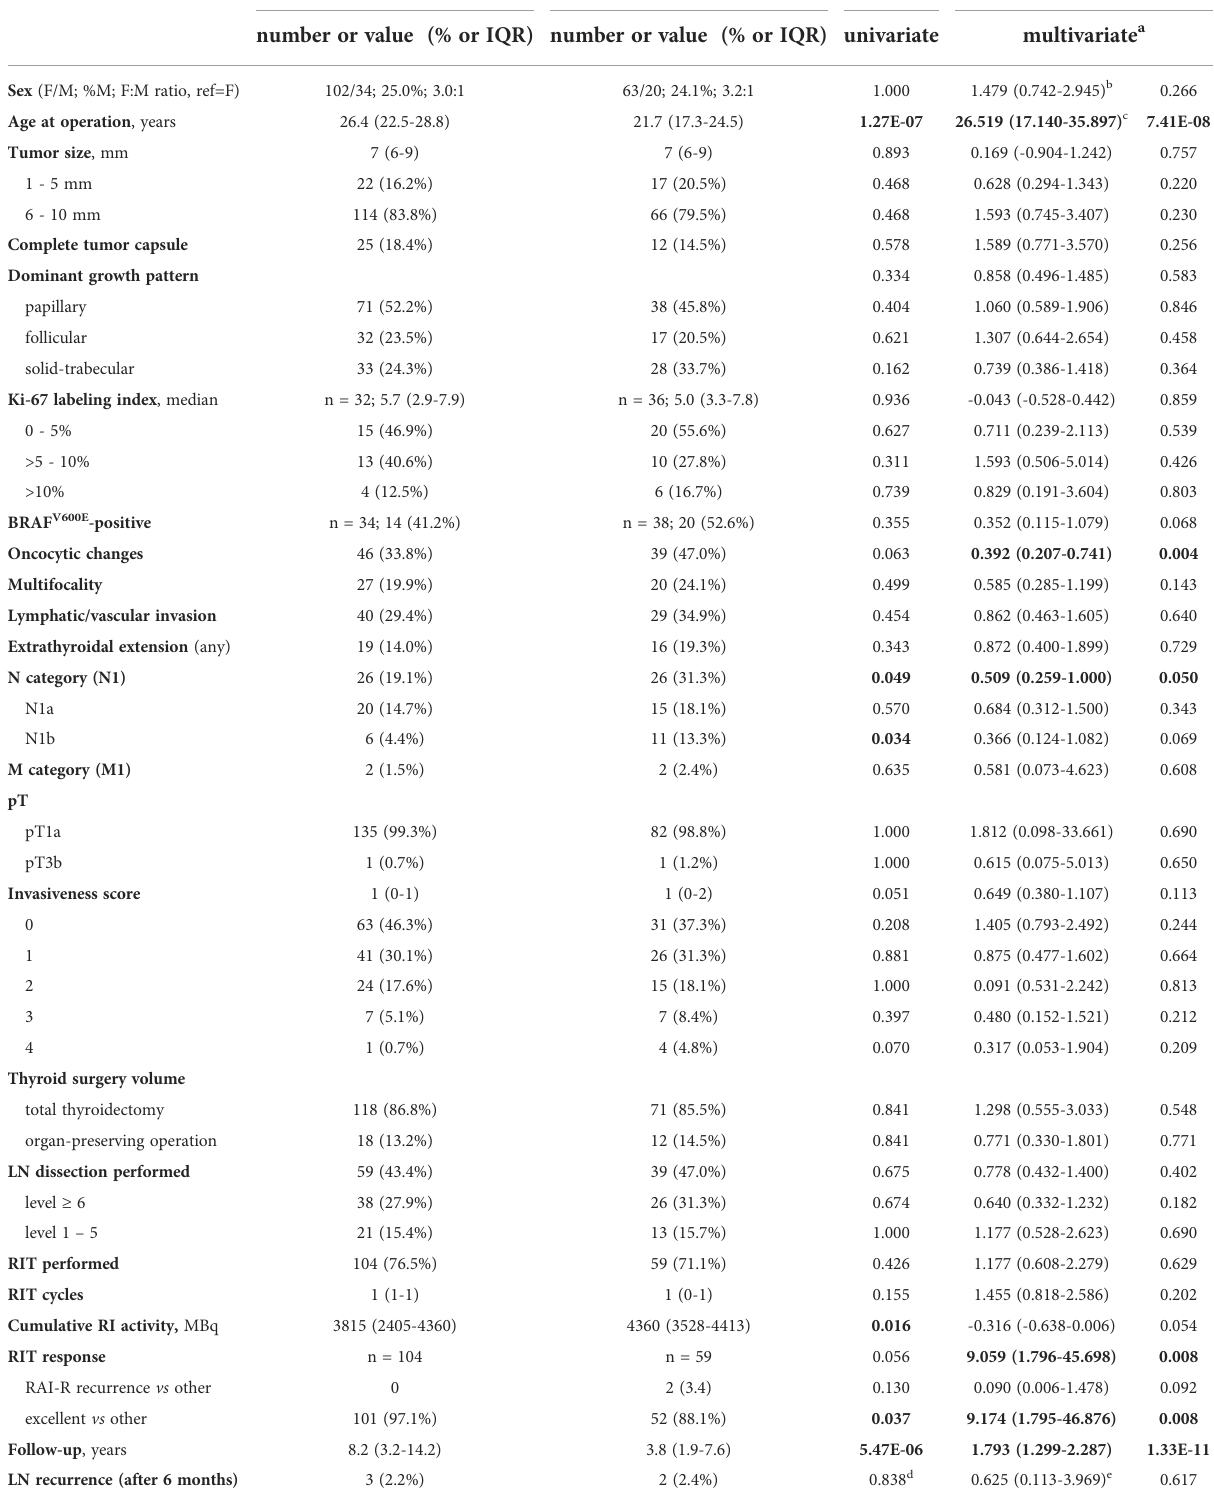
TABLE 1 Characteristics of the radiogenic and sporadic papillary thyroid microcarcinomas in patients aged up to 30